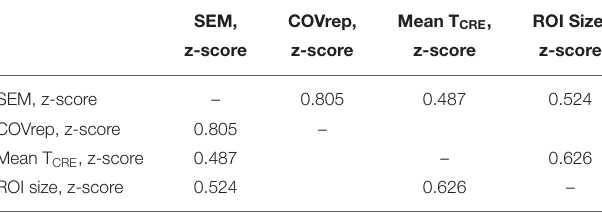
TABLE 5 | Pearson correlations between measures of reproducibility and repeatability (SEM and COVrep), mean T CRE , and ROI